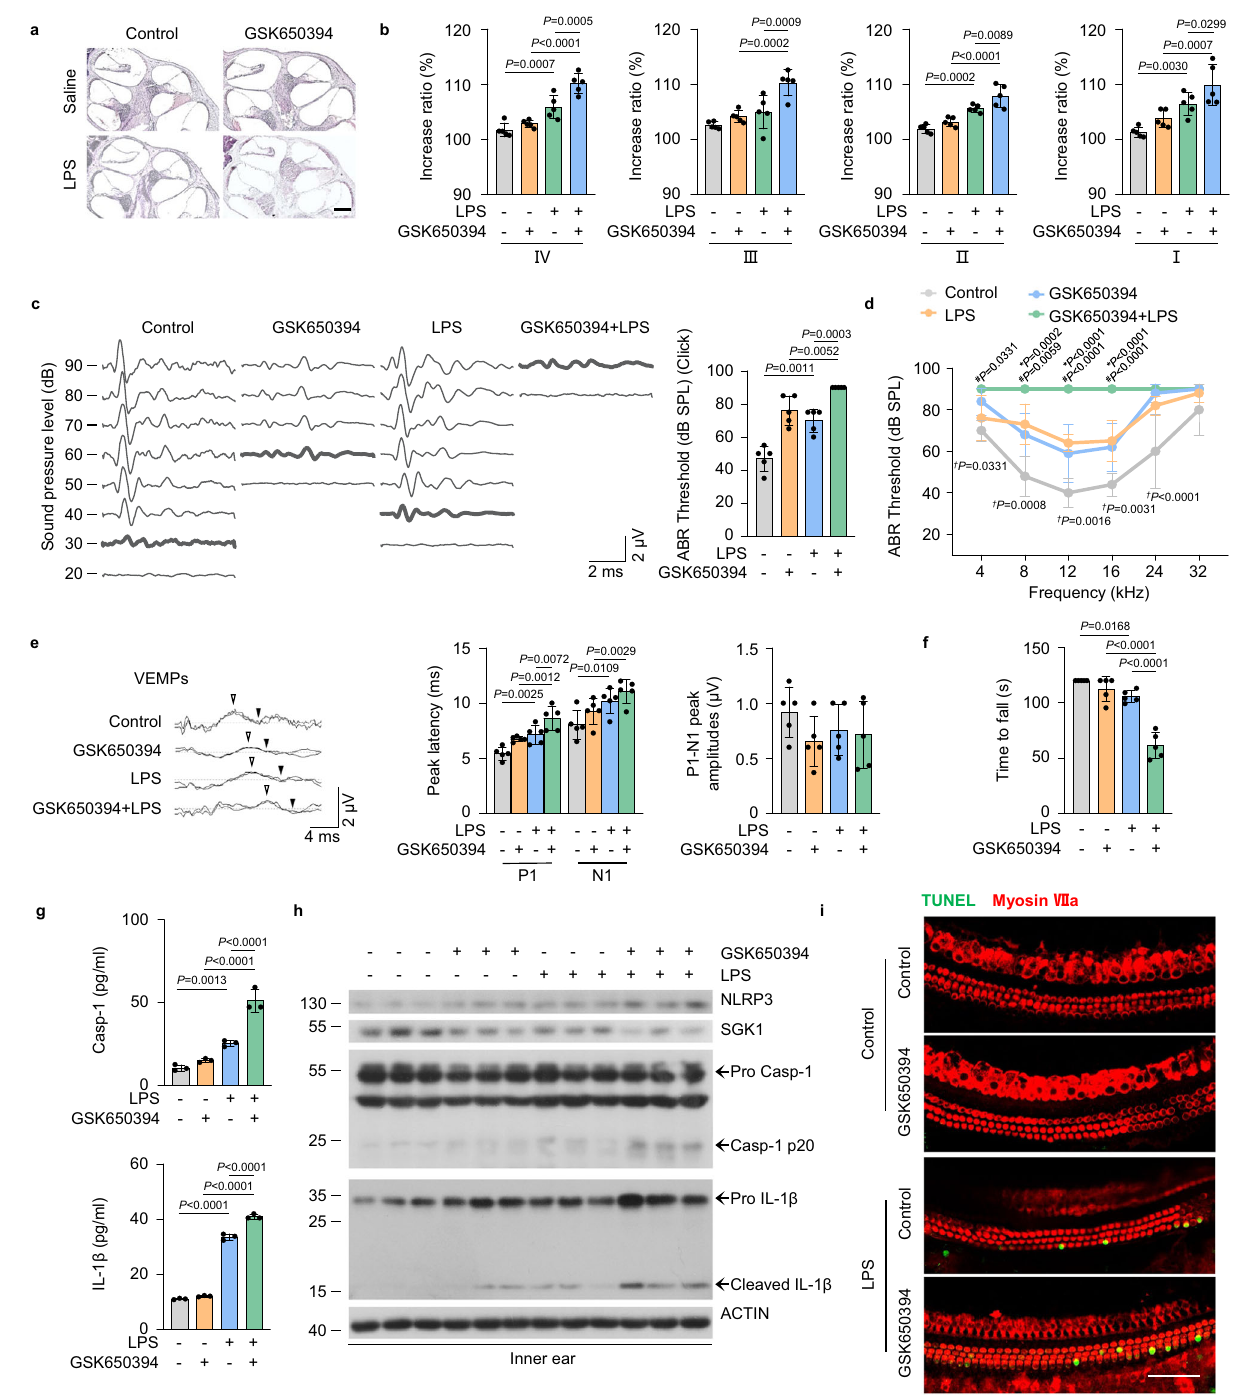
Fig. 6 | Pharmacological inhibition of SGK1 increases the severity of LPS- induced EH and audiovestibular symptoms in vivo. a – i The WT mice were untreated or pretreated with GSK650394 and challenged with LPS or saline. a Representative images of mid-modiolar cochlear sections, scale bar = 200 μ m. b Measurements of IR-L in cochlear half-turns I – IV ( n =5 mice per group). c Representative serial ABR wave recordings and thresholds in response to click sounds ( n =5 mice per group). d ABR thresholds in response to pure tone burst across all frequencies tested (4, 8, 12, 16, 24, and 32kHz) ( n =5 mice per group). * P indicates p -values for GSK650394+LPS versus LPS; # P indicates p -values for GSK650394+LPS versus GSK650394; † P indicates p -values for LPS versus Control. e Representative click-evoked VEMPs waves, P1-N1 peak amplitudes, and the P1